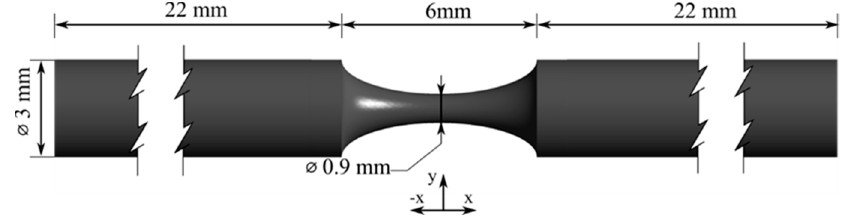
Figure 1. Dimensions of the 70% stenotic model.